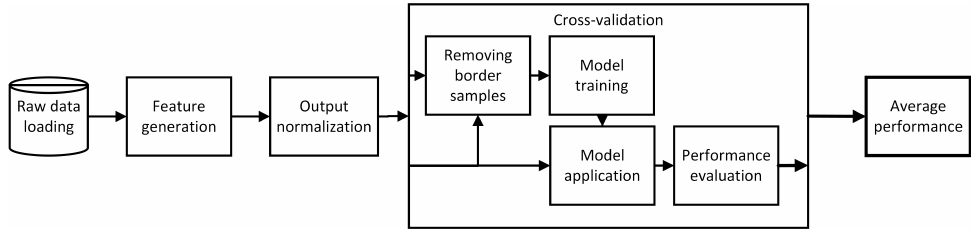
Figure 4. The scheme of the model evaluation process.